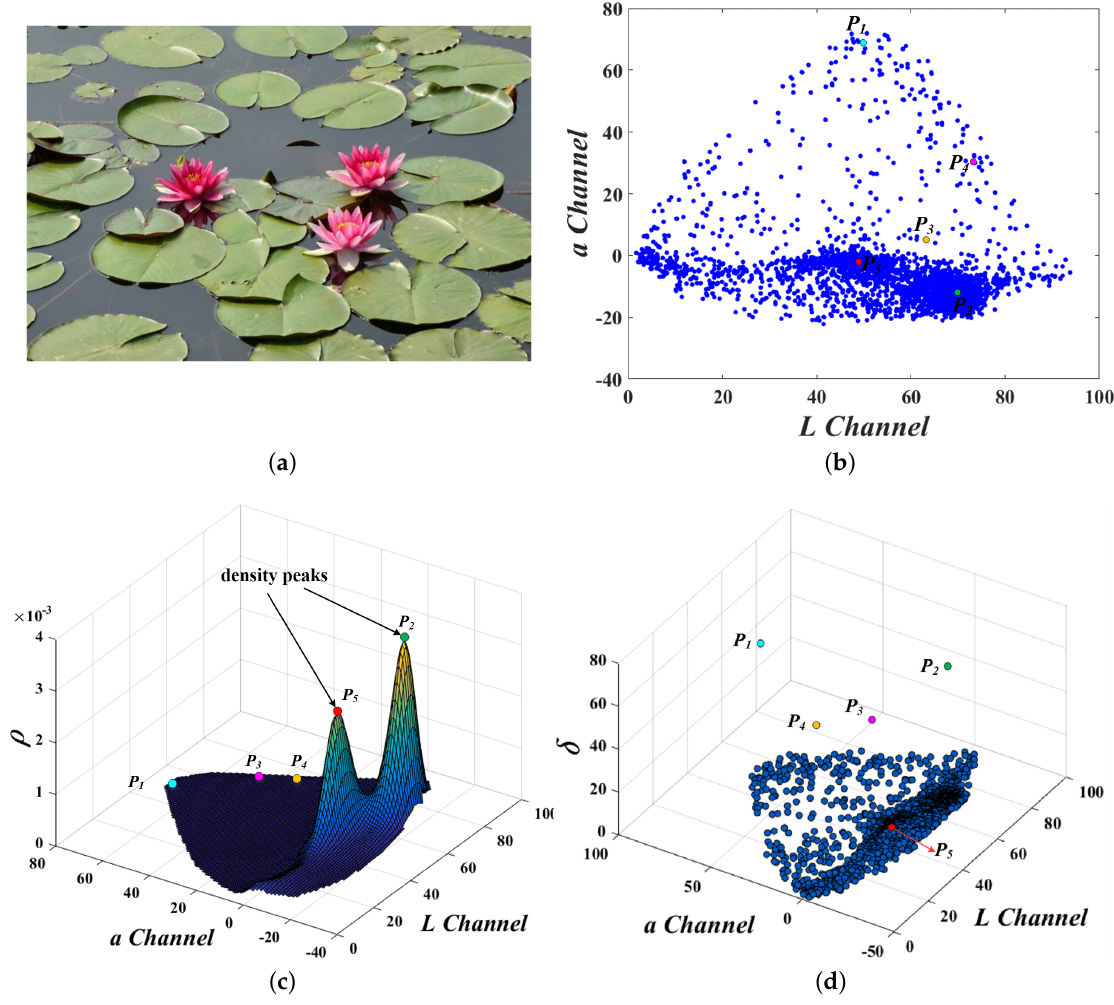
Figure 4. ( a ) Original image. ( b ) The 2-d color feature space for all sample points from image ( a ), which is represented through the strategy illustrated in Figure 3. ( c ) Local density ρ for sample points, which are shown as 3D shaded surface plot of the probability density function. ( d ) Distributions of discrete distance δ for 3D condition, which are computed by using Equation